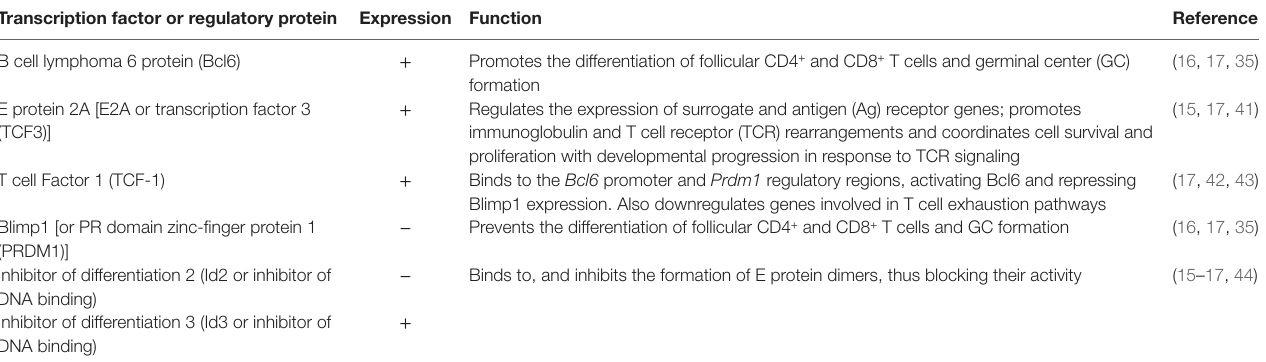
TABLe 2 | Transcription factors and regulatory proteins driving differentiation of CXCR5 + CD8 + T cells. Transcription factor or regulatory protein expression Function Reference